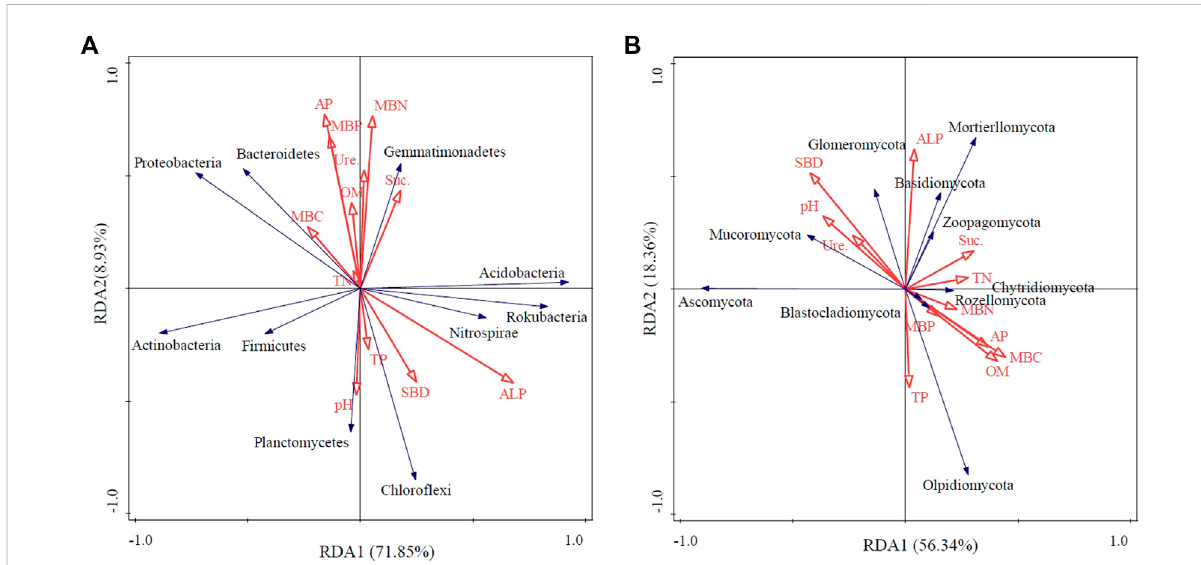
FIGURE 6 Redundancy analysis (RDA) of bacterial (A) and fungal (B) communities at the phylum level with soil variables. SBD, soil bulk density; SOM, soil organic matter; TN, total nitrogen; TP, total phosphorus, AP, available phosphorus, MBC, microbial biomass carbon; MBN, microbial biomass nitrogen; MBP, microbial biomass phosphorus, Suc., soil sucrase; Ure., soil urease, and ALP, soil alkaline phosphatase.